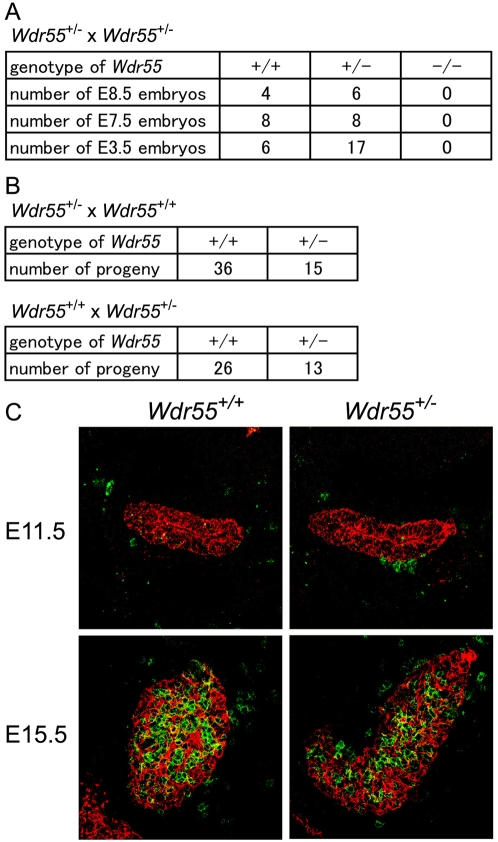
WDR55 deficiency in mouse causes developmental arrest before implantation.(A) Genotype of mouse embryos from Wdr55+/−× Wdr55+/− crosses at indicated embryonic days. (B) Genotype of mouse progenies from the mating of Wdr55+/− females×Wdr55+/+ males (top) and Wdr55+/+ females×Wdr55+/− males (bottom). (C) Thymus development in Wdr55+/− embryos. Cryosections of developing thymus in Wdr55+/+ (left) and Wdr55+/− (right) embryos at E11.5 (top) and E15.5 (bottom) were stained with anti-CD45 (green) and anti-cytokeratin (red) antibodies.